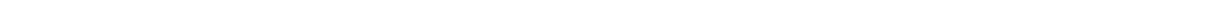
Figure 2 | Spike sorting and assessment of long-term stability of single-unit recordings by single microwire array over 7 days. ( a ) Example of spike sorting from single microwire array in 7 days, showing the superimposed spike waveforms (upper panel) and the inter-spike-interval histogram (ISIH, lower panel), and the corresponding identified clusters in the PCs space (far right panel). Clear isolation of units from a given recording channel is indicated by high, F statistic of MANOVA (F), J3, Dunn validity (Dn) and low Davis-Bouldin (DB) index (see Methods). Note the excluded unit in red, whose spike waveforms changed cross days, and had shifted ISI histogram and cluster location in PCs. ( b ) Long-term stability of identified single-units shown in a over 7 days. The unit shown in red with drifting of cluster was excluded. ( c ) Autocorrelograms of the three isolated units and their cross-correlogram (white). The presence of refractory periods in the auto-correlograms and absence of refractoriness in the cross-correlogram indicated spikes with clusters marked in yellow, green and blue were generated by three distinct neurons. The short latency sharp peak in the cross-correlogram (arrow) between the putative pyramidal neuron (yellow, reference of the cross-correlogram) and the interneuron (green) may indicate mono-synaptic activation. ( d ) Example of units exhibiting stable (top, unit 1 in a ) or unstable (bottom, unit 4 in a ) spike waveform are shown in d . ( e ) Gaussian mixture distributions fitted to combinations of the four similarity scores (see Methods) computed from spikes recorded from same neuron (black dots, representing true positive values computed using recording acquired in difference sessions on the same day, see Methods) or distinct ones (grey dots, computed from recordings from different channels simultaneously) on the same day corresponding contours: 50% (red), 95% (blue), 99.9% (orange), 99.97% (black) of the distribution. Red and blues crosses represented recordings classified as stably corresponding to the same or arising from distinct neurons respectively, based on combining the use of multiple similarity scores with quadratic classifiers (green lines). ( f ) Cross-day stability of single-unit isolation quality assessed by L-ratio and isolation distance ( n ¼ 158 included units shown in red in e ). ( g ) Cross-day stability of four cluster similarity scores ( n ¼ 158 included units shown in red in e , day 1 session 1 recordings were used as